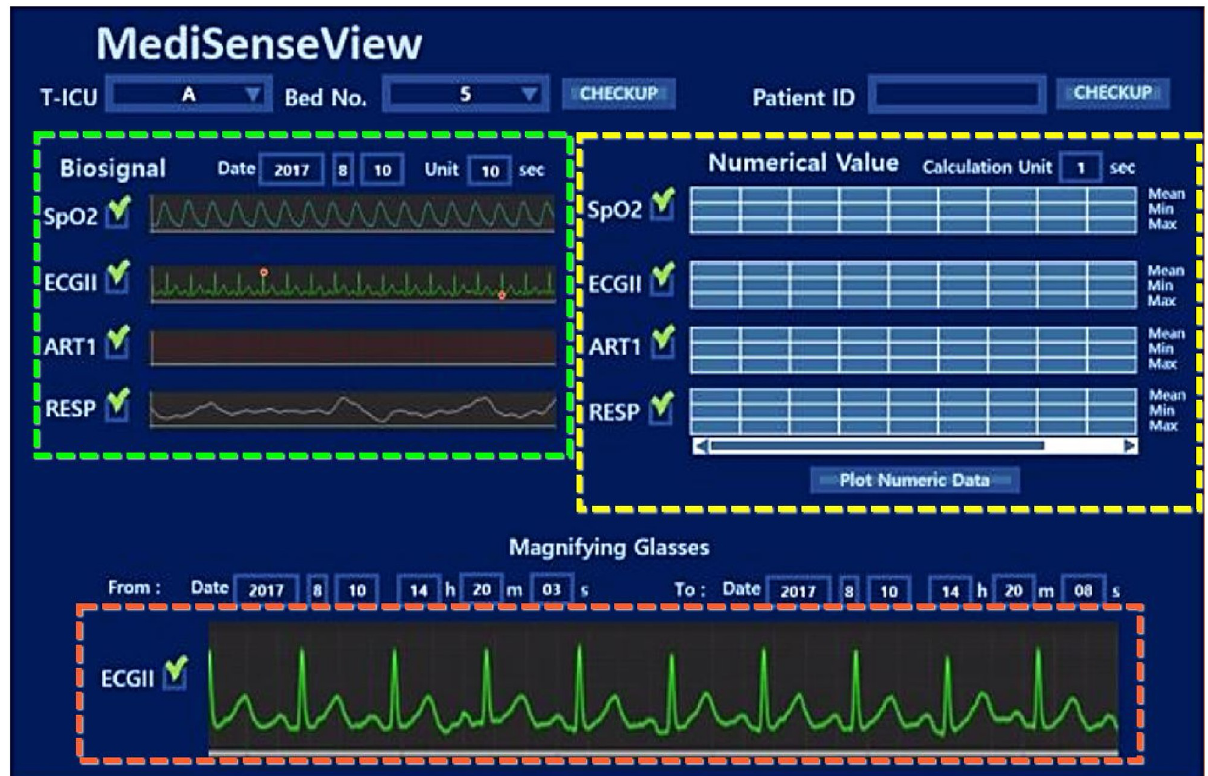
Fig 8. The first prototype of MediSenseView . We used this version for discussions in the first design meeting.